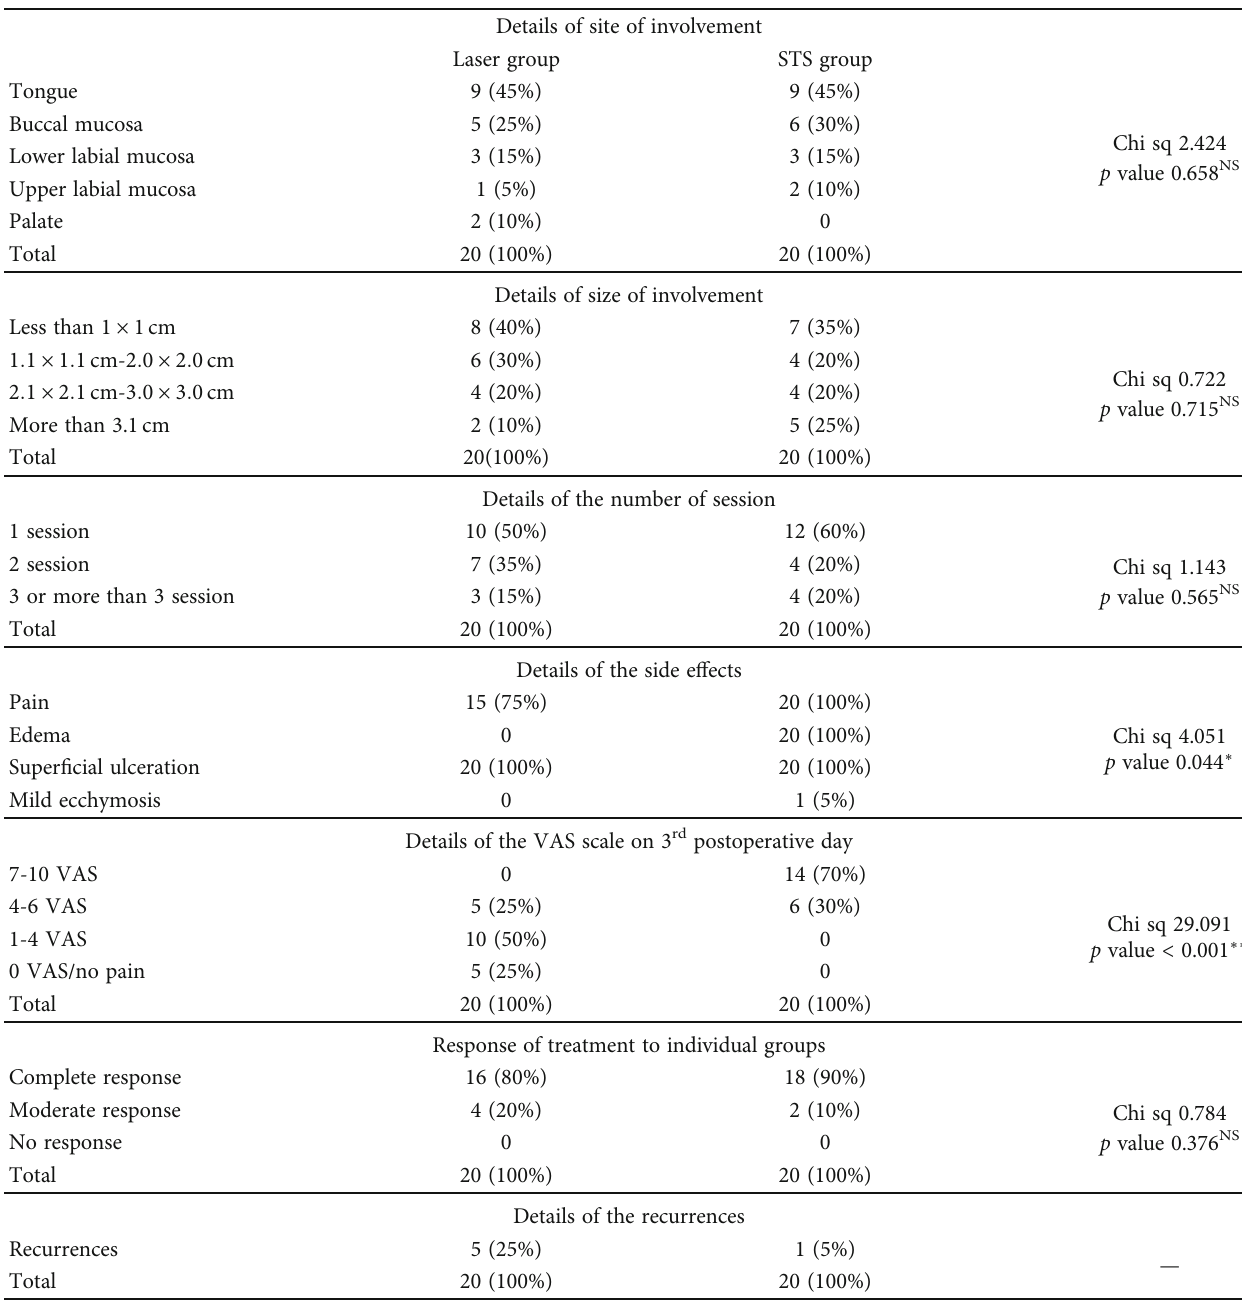
Table 2: Details of comparison between diode laser and